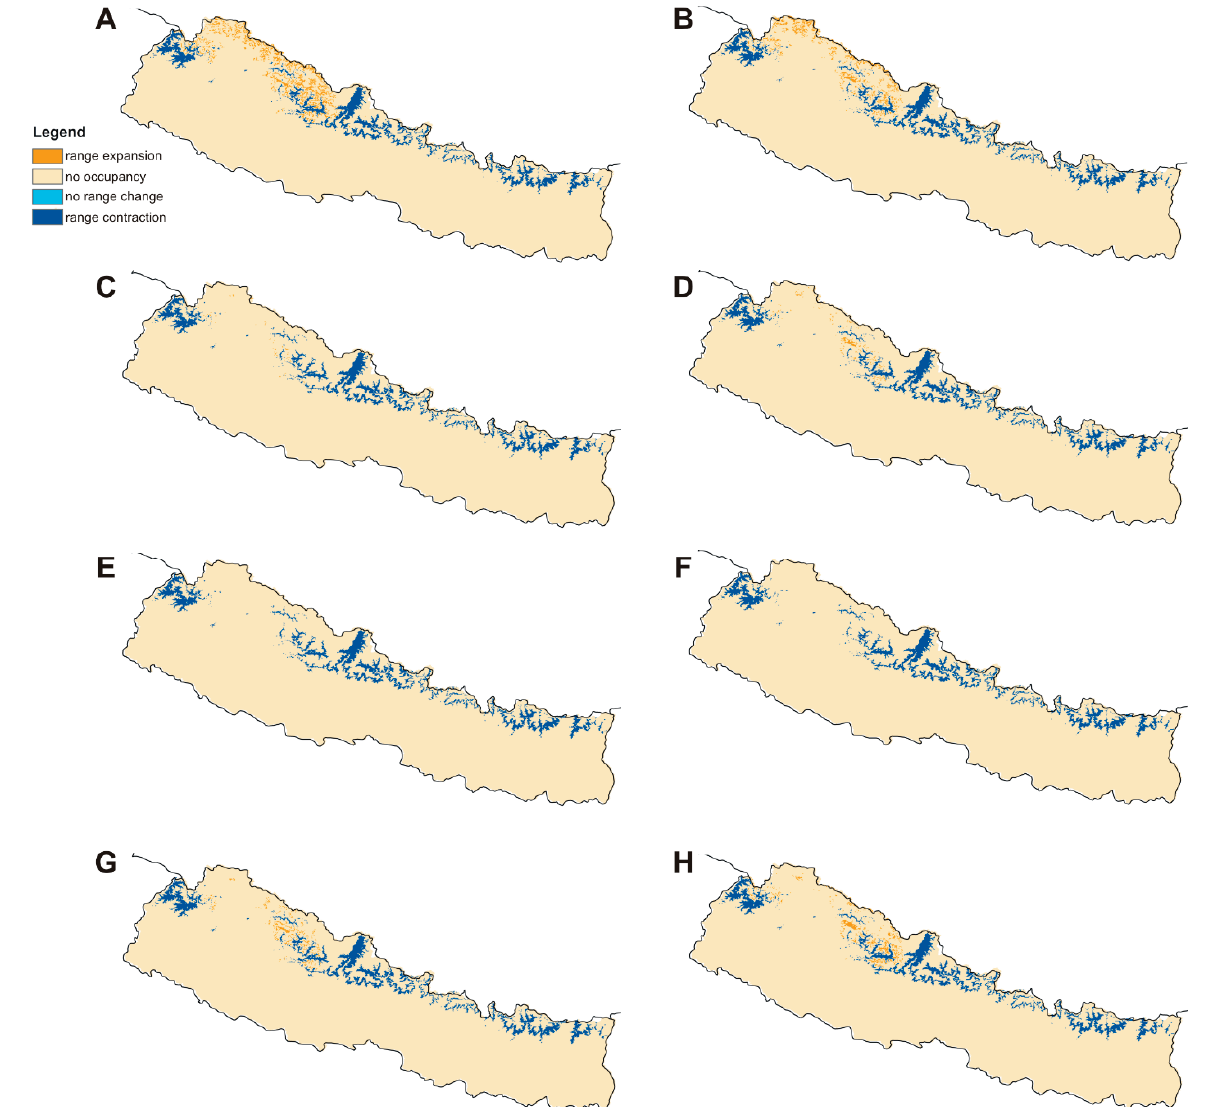
Figure 10. Changes in the distribution of suitable niches of Dactylorhiza hatagirea in 2070 according to RCP4.5 ( A , C , E , G ) and RCP8.5 ( B , D , F , H ) climate change scenarios. ( A , B ), BCC-CSM1-1 model; ( C , D ), CCSM4 model; ( E , F ), HadGEM2-ES model; ( G , H ), MIROC5 model.